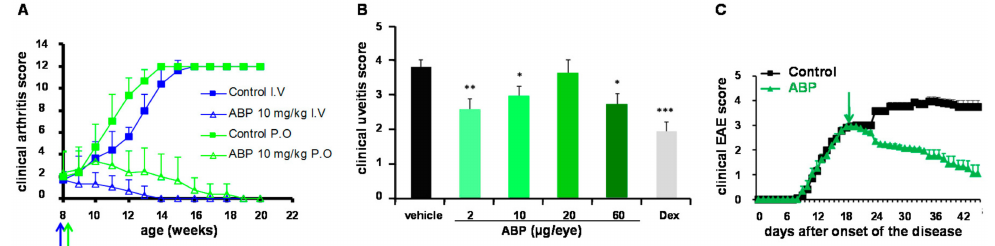
Figure 7. Proof of efficacy of the ABP dendrimer in animal models of inflammatory